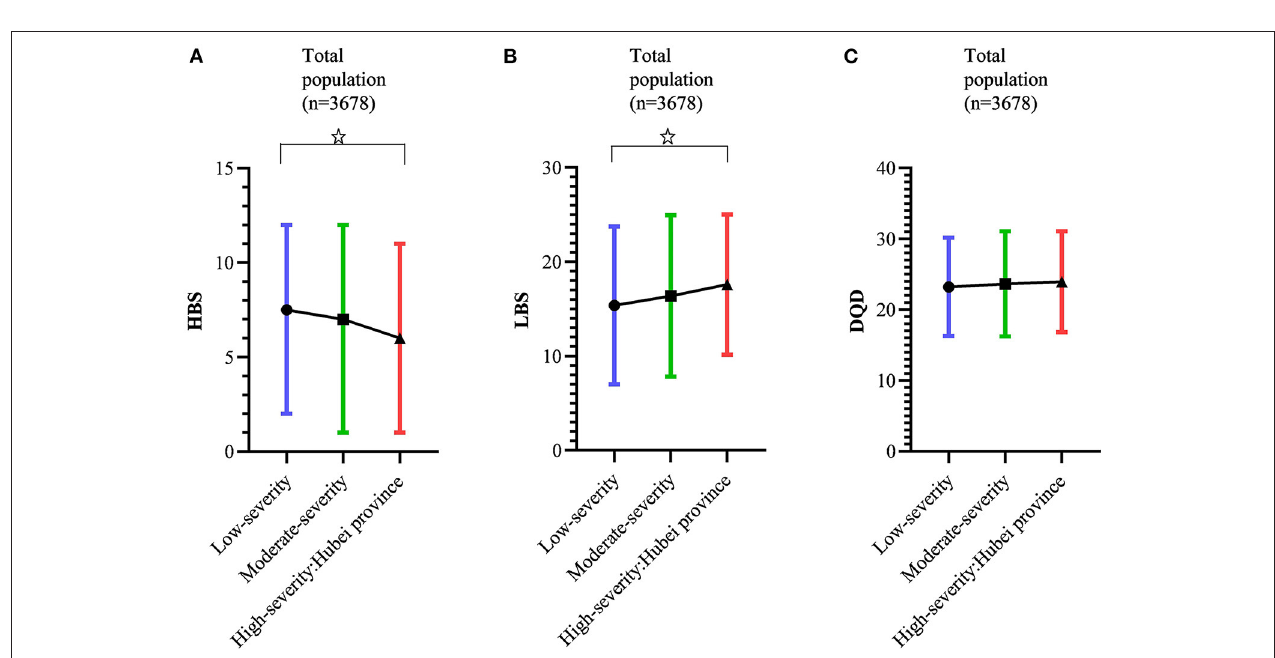
FIGURE 4 | Variation of diet quality (Diet Balance Index for Pregnancy, DBI-P) according to COVID-19 pandemic severity. (A) Variation of high bound score (HBS) according to COVID-19 pandemic severity. (B) Variation of low bound score (LBS) according to COVID-19 pandemic severity. (C) Variation of diet quality distance (DQD) according to COVID-19 pandemic severity. HBS were presented as median (interquartile range, IQR). LBS and DQD were presented as mean (standard deviation, SD). ☆ Linear trends were statistically significant ( p <